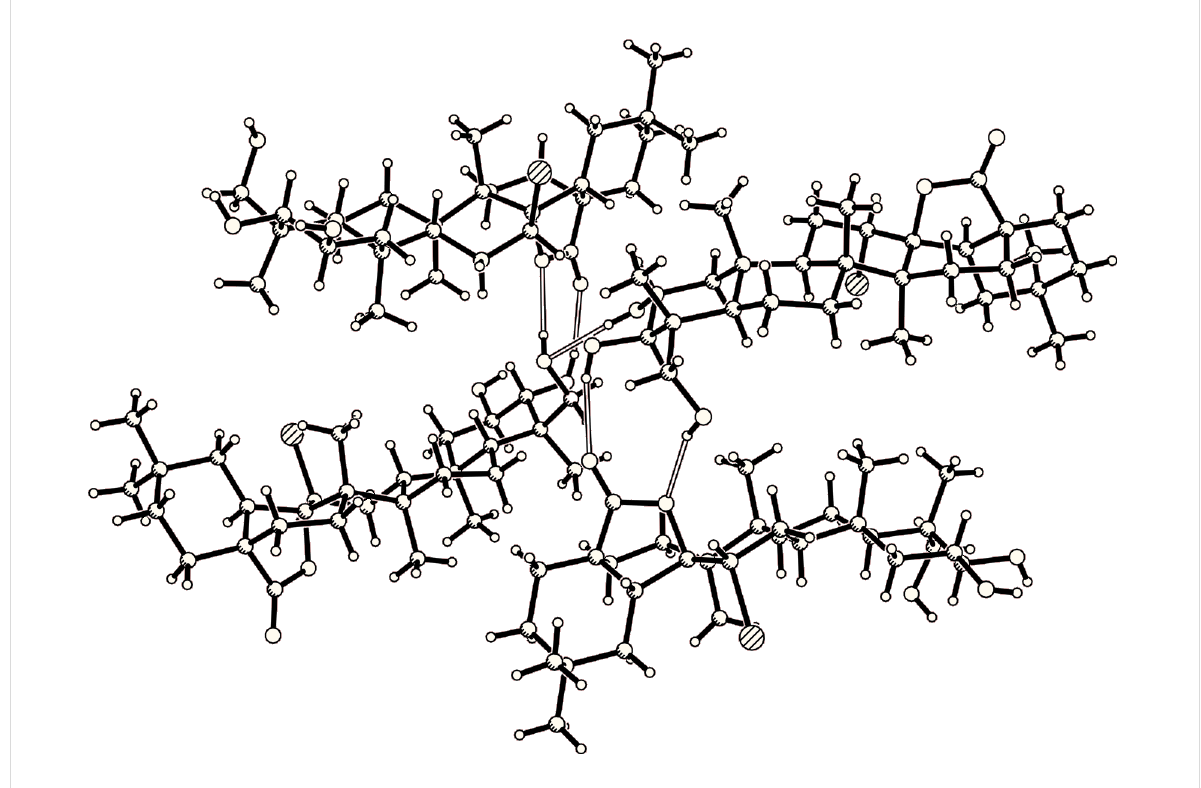
Figure 4: Crystal packing diagram of arjuna-bromolactone 3 . A network of hydrogen bridges leading to the formation of a one-dimensional helix is